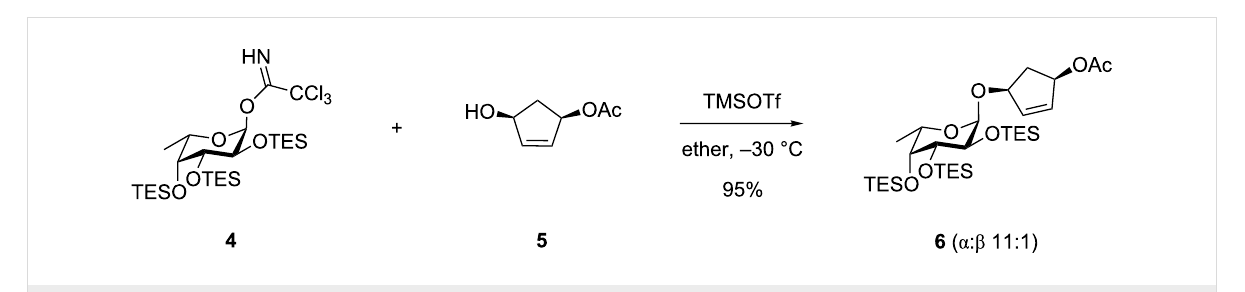
Scheme 2: Glycosylation with imidate 4 .